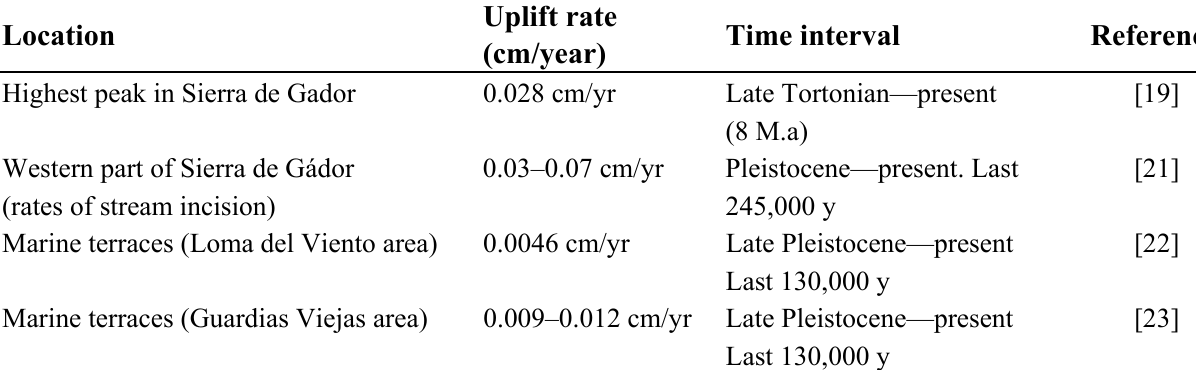
Table 2. Uplift rates from several authors in the studied